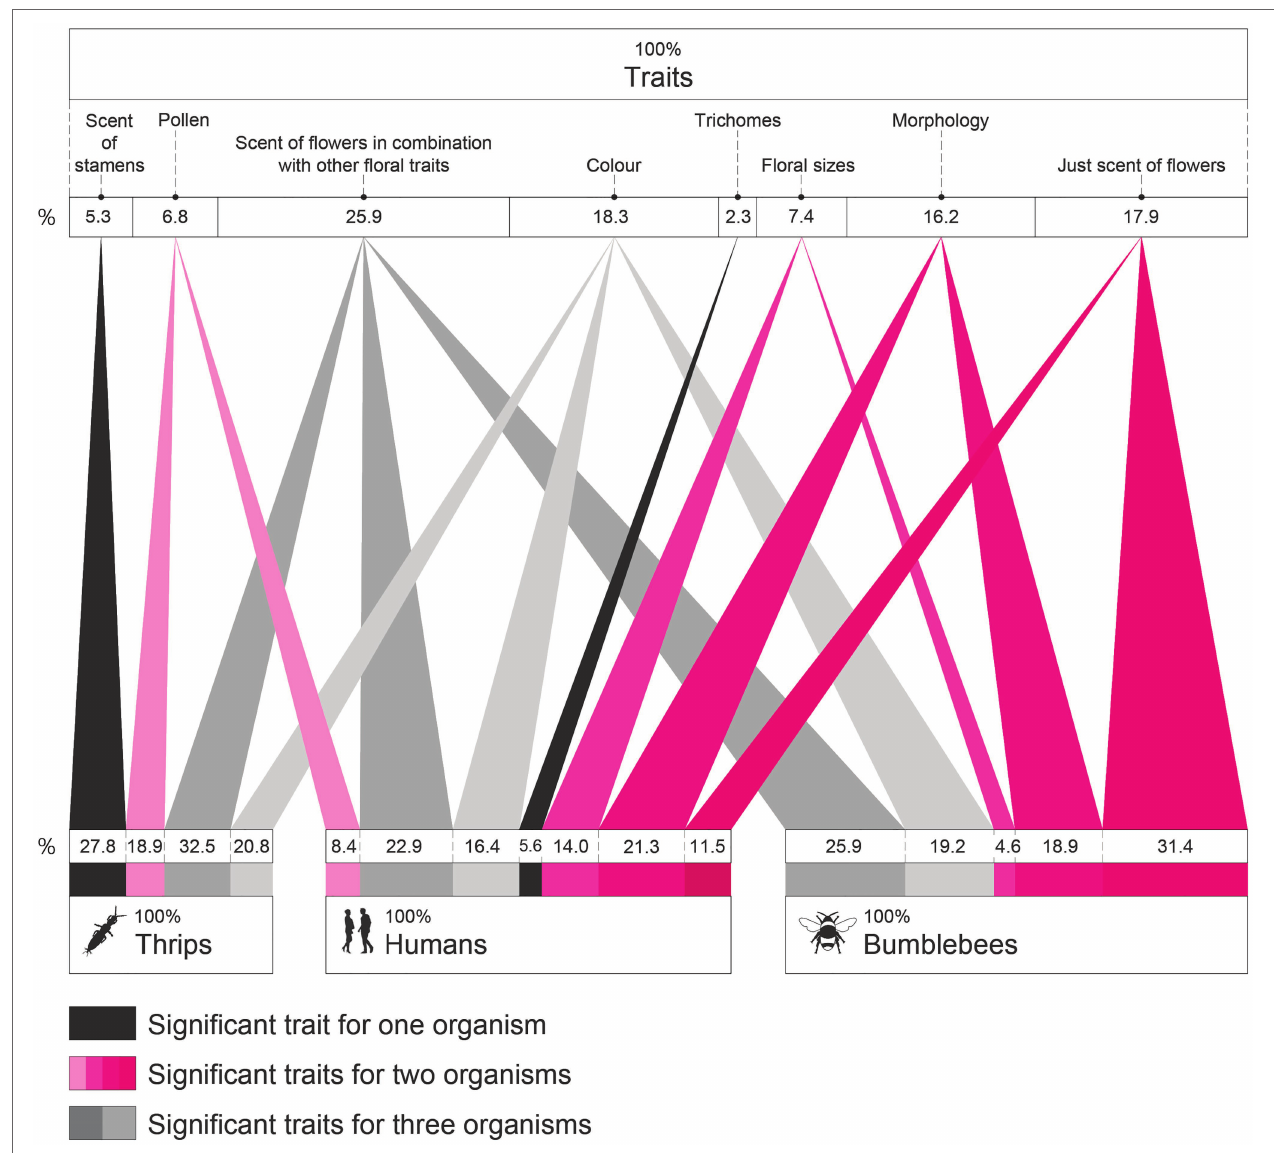
FIGURE 6 | Bipartite network of statistically significant relations of the preferences of bumblebees, humans, and thrips for groups of floral traits. Colour of edges represents: traits relevant for all organisms (grey), for two organisms (pink), or for just one organism (black). Only significant traits ( p < 0.05) are represented for each organism. Width of edges is proportional to r 2 for each organism and trait. Percentages indicated are calculated based on the width of each trait. In the upper part of the graph, percentages represent the relative importance of each trait analysed for the three kind of organisms together. In the lower part of the graph, percentages represent the relative importance of traits for each kind of organism separately (thrips, humans, and